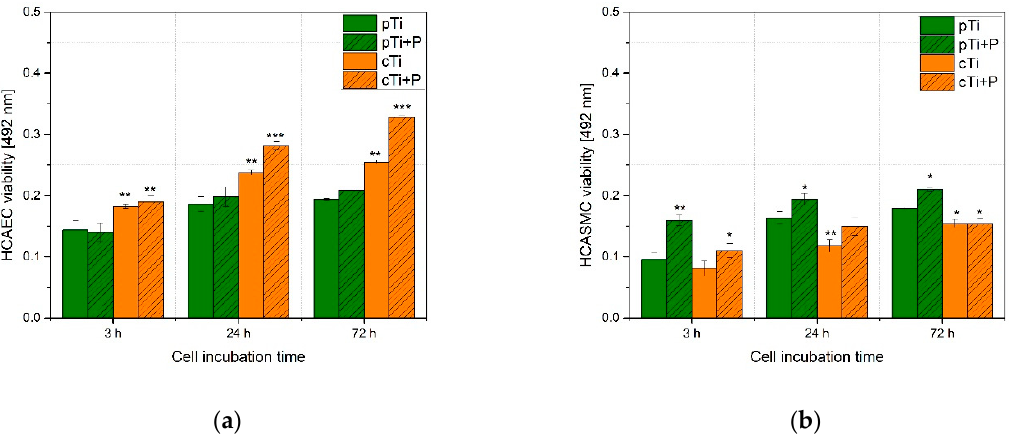
Figure 12. Results of the MTT assay for: ( a ) HCAEC and ( b ) HCASMC cell proliferation on pTi , cTi , pTi+P, and cTi+P surfaces. The error bars represents standard error. Symbols * represent a statistically significant change in viability after 3, 24, and 72 h (represents statistical significance at * p < 0.05, ** p < 0.01, and *** p < 0.001 compared with the pTi ). Mean values (±SE) for the respective triplicates are presented.